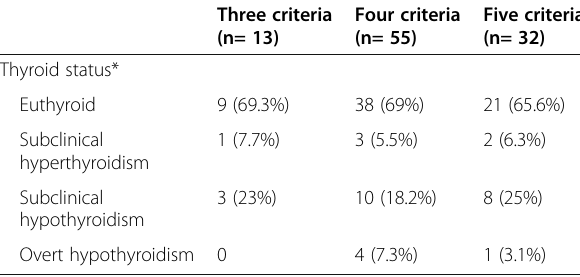
Table 5 Frequency of thyroid dysfunction based on criteria of metabolic syndrome